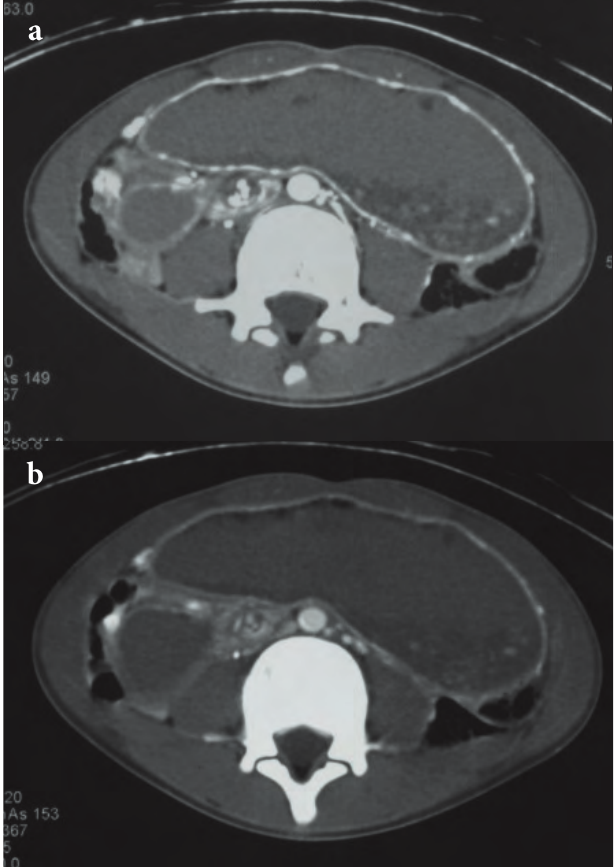
Fig. 4. Computed tomography (CT) with intravenous contrast in (a) the arterial phase and (b) the portal venous phase demonstrates the classic sign of whirling of the mesenteric vessels around the superior mesenteric artery (SMA), in keeping with